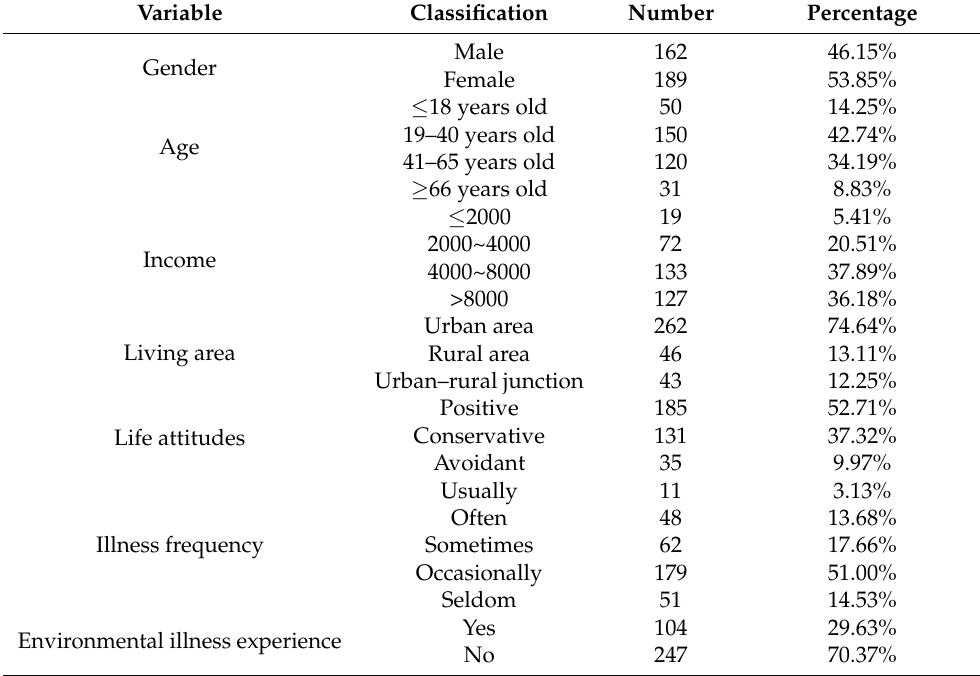
Table 1. Individual characteristics of the